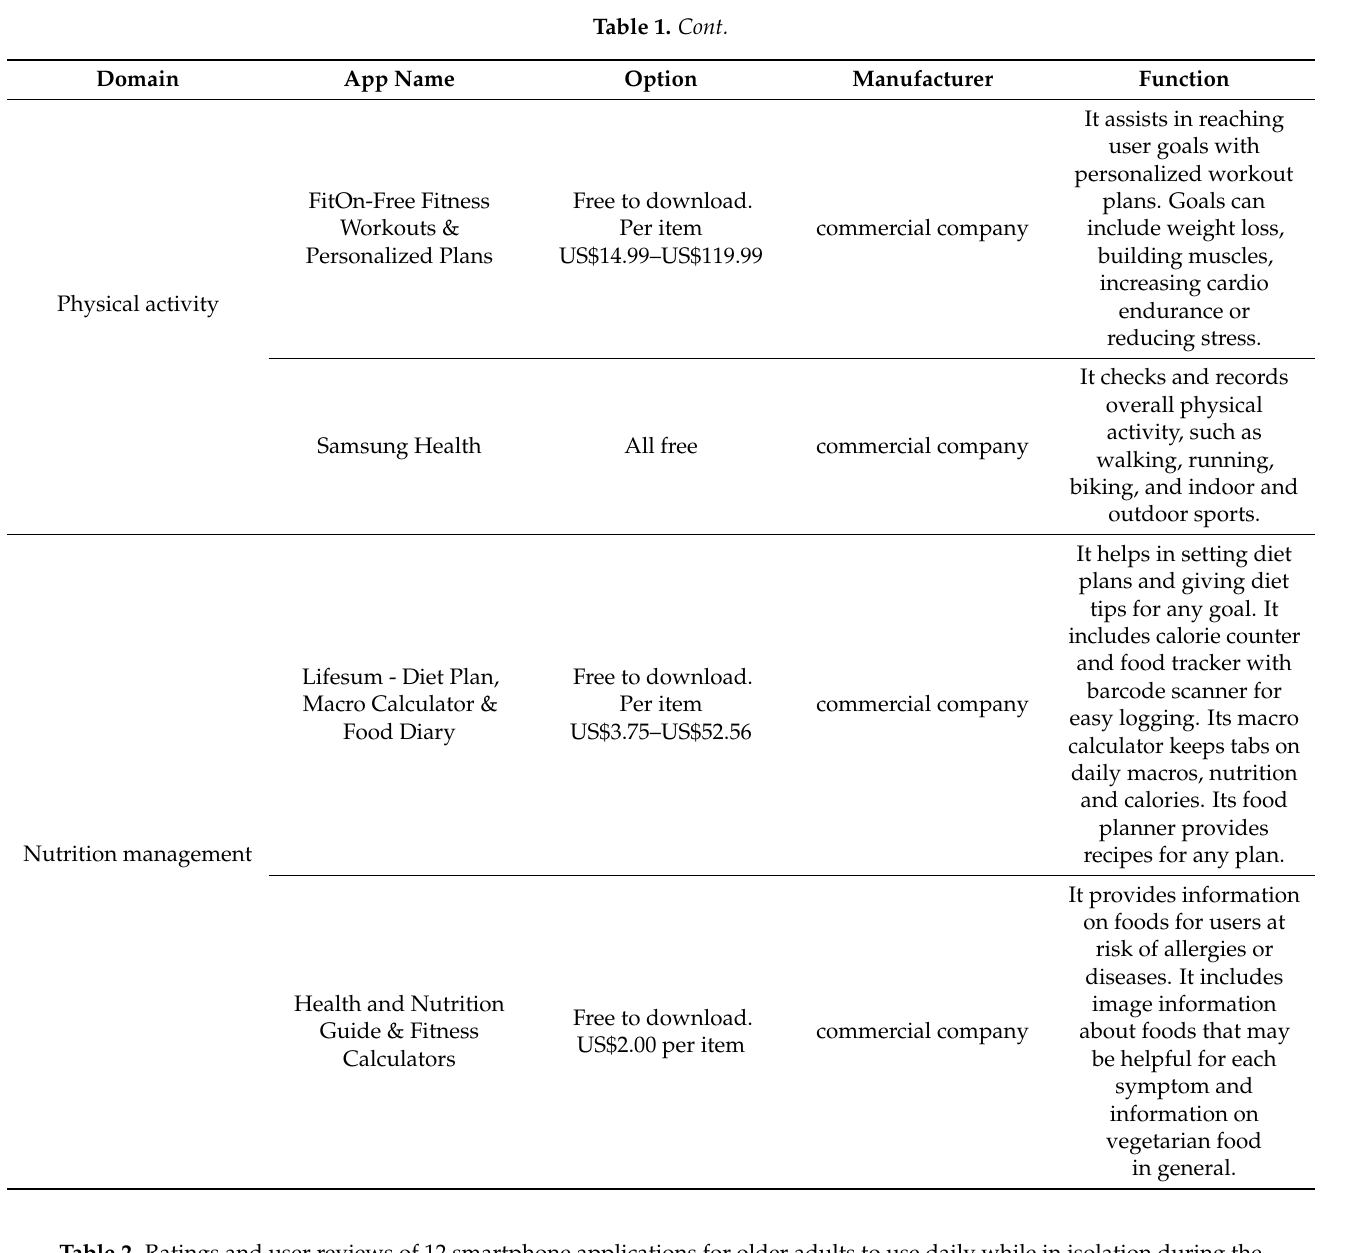
Table 2. Ratings and user reviews of 12 smartphone applications for older adults to use daily while in isolation during the COVID-19